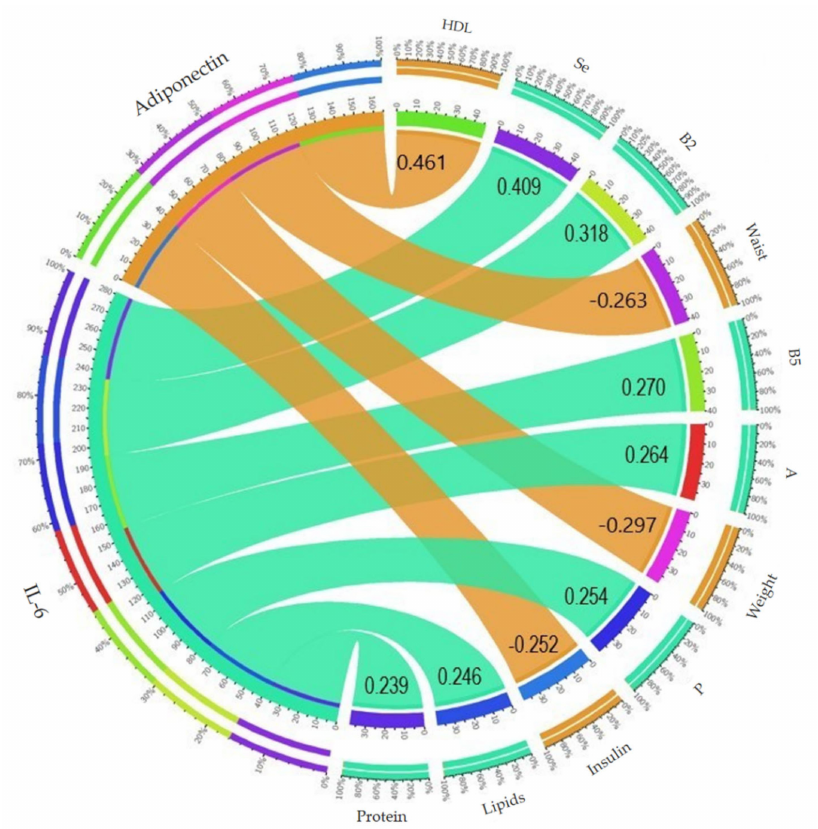
Figure 5. Correlation of adiponectin (orange shades) and interleukin-6 (green tones) with the variables evaluated (figure created in Circos Table Viewer software, vo. 63–9, Genome Sciences Centre, Vancouver,